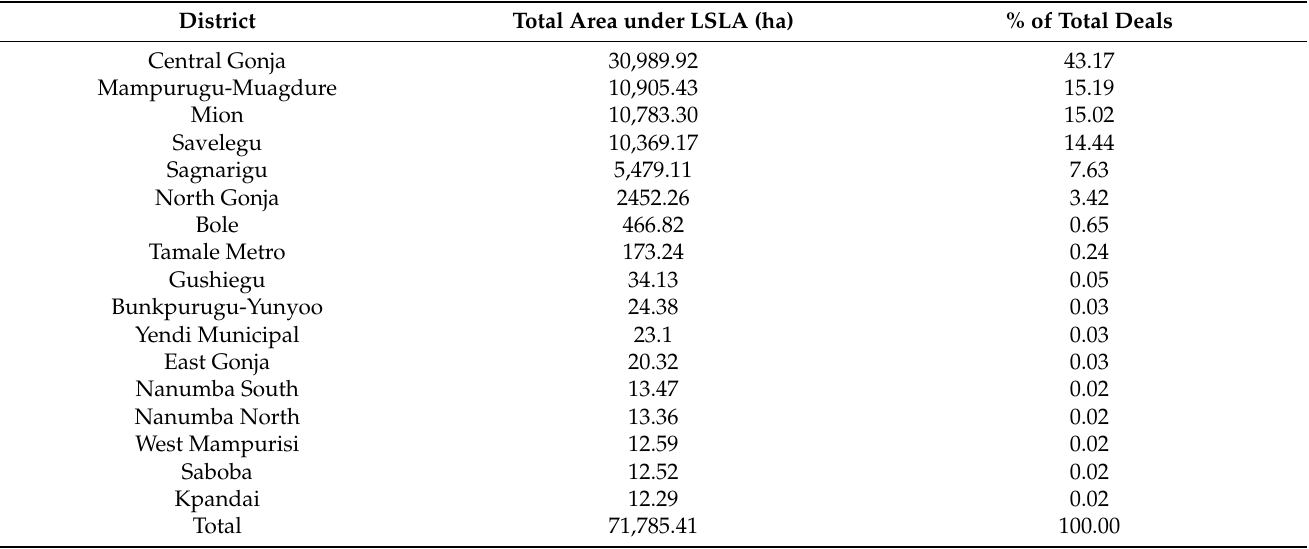
Table A3. Scale of arable land under commercial deals by